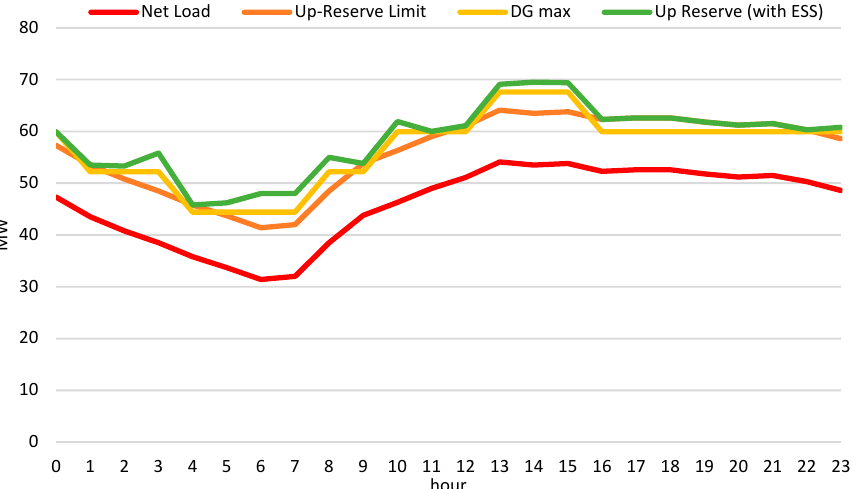
Figure 9. Case 2 hourly power generation of each fuel generator.